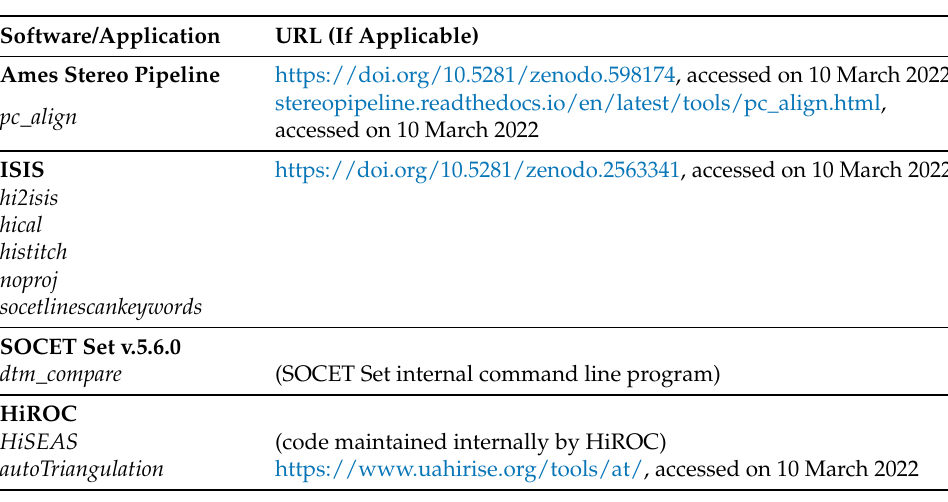
Table A1. List of programs referred to in the text, with URLs if available.